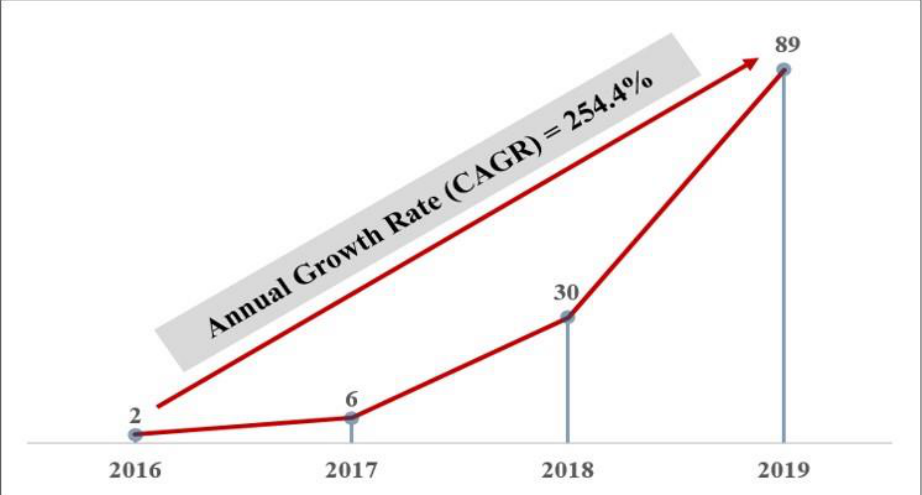
Figure 3. Distribution of the articles by publication year (2016~2019) (note: CAGR: Compound Annual Growth Rate; As of 10 March in 2020, 8 articles were published in 2020 but they were not included in this figure).